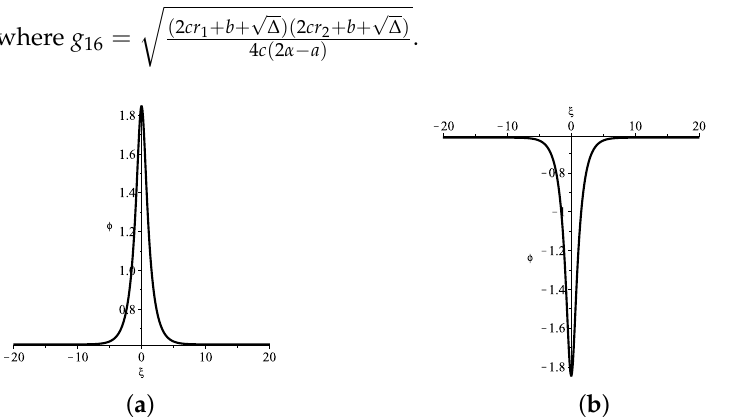
Figure 27. Solitary wave forms of system (5). ( a ) Bright solitary wave derived by (68) + . ( b ) Dark solitary wave derived by (68) −